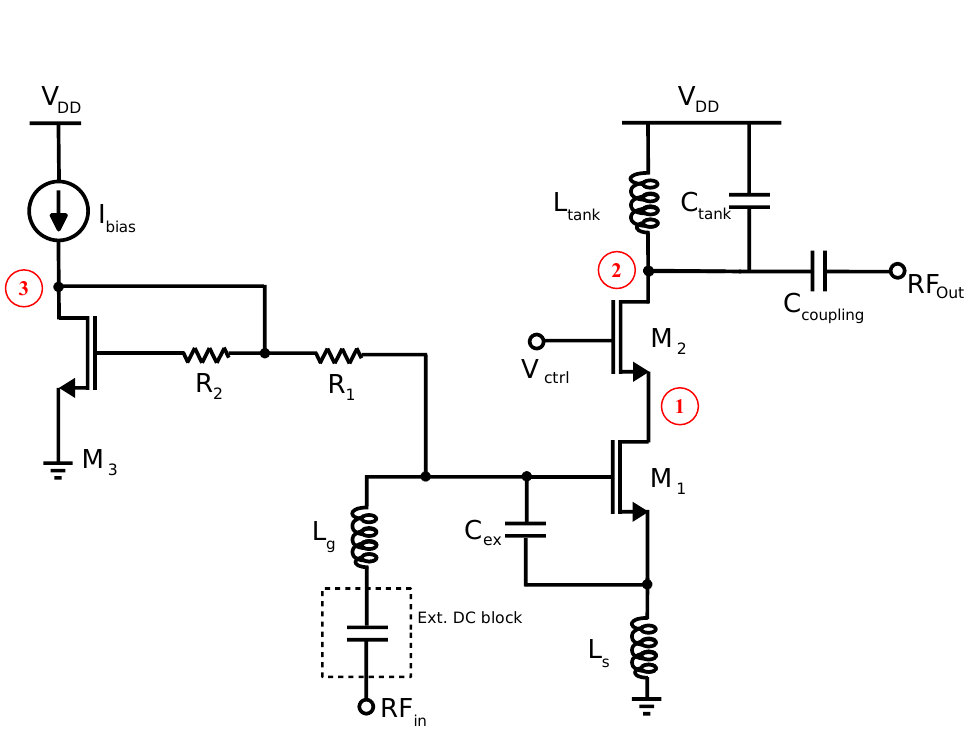
Figure 2. Schematic of the common-source cascode